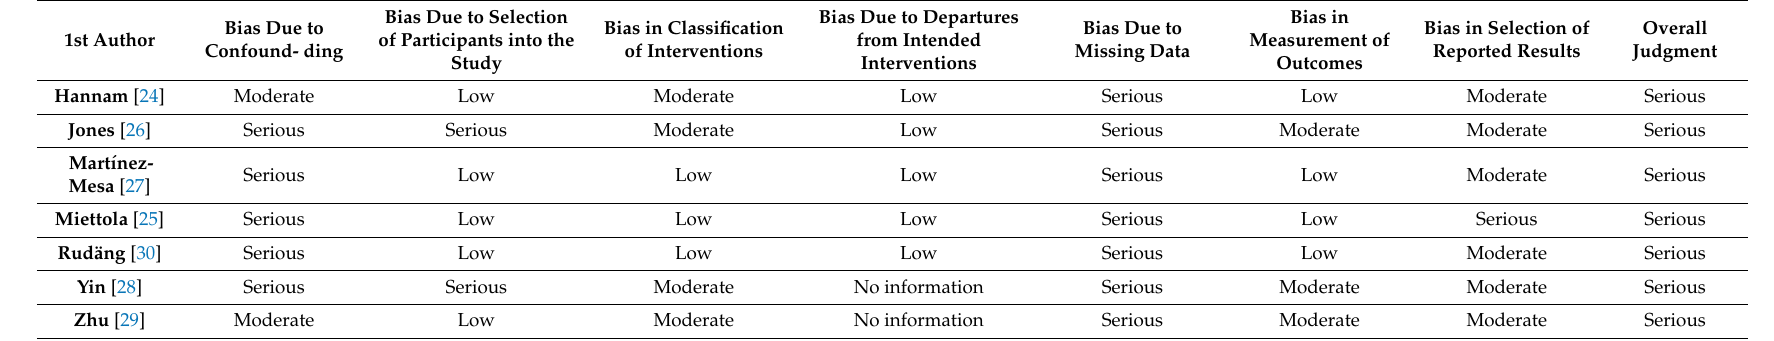
Table 2. Summary table of the risk of bias in the included studies evaluated using “Risk Of Bias In Non-randomized Studies of Interventions” (ROBINS-I). The overall judgment of risk of bias equals the most severe level of bias found in any